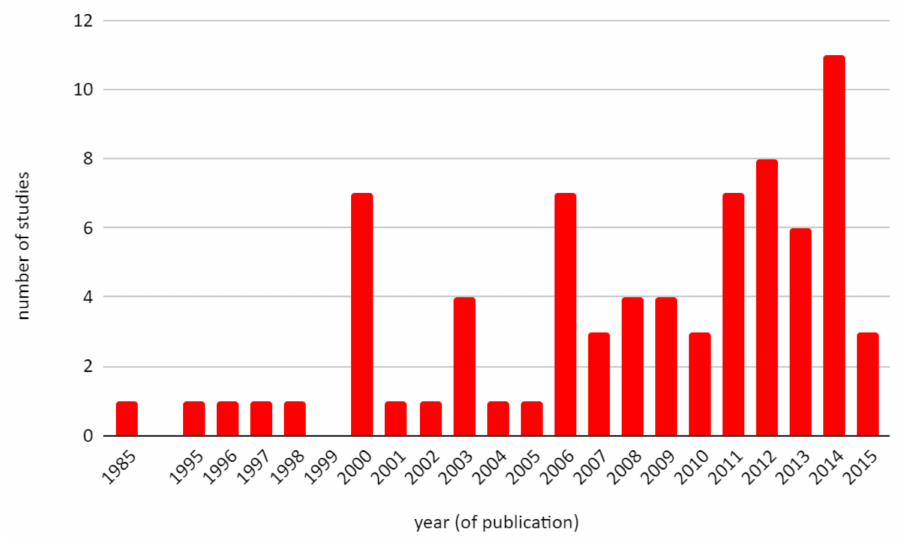
Figure 2. Number of studies by year of publication.